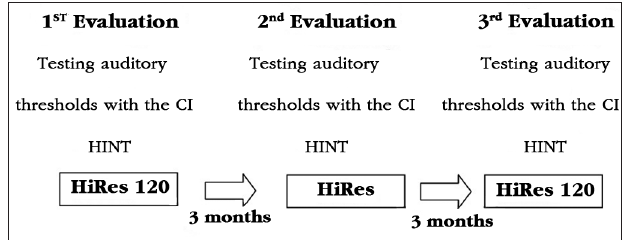
Figure 1. Schematic representation of the evaluation protocol